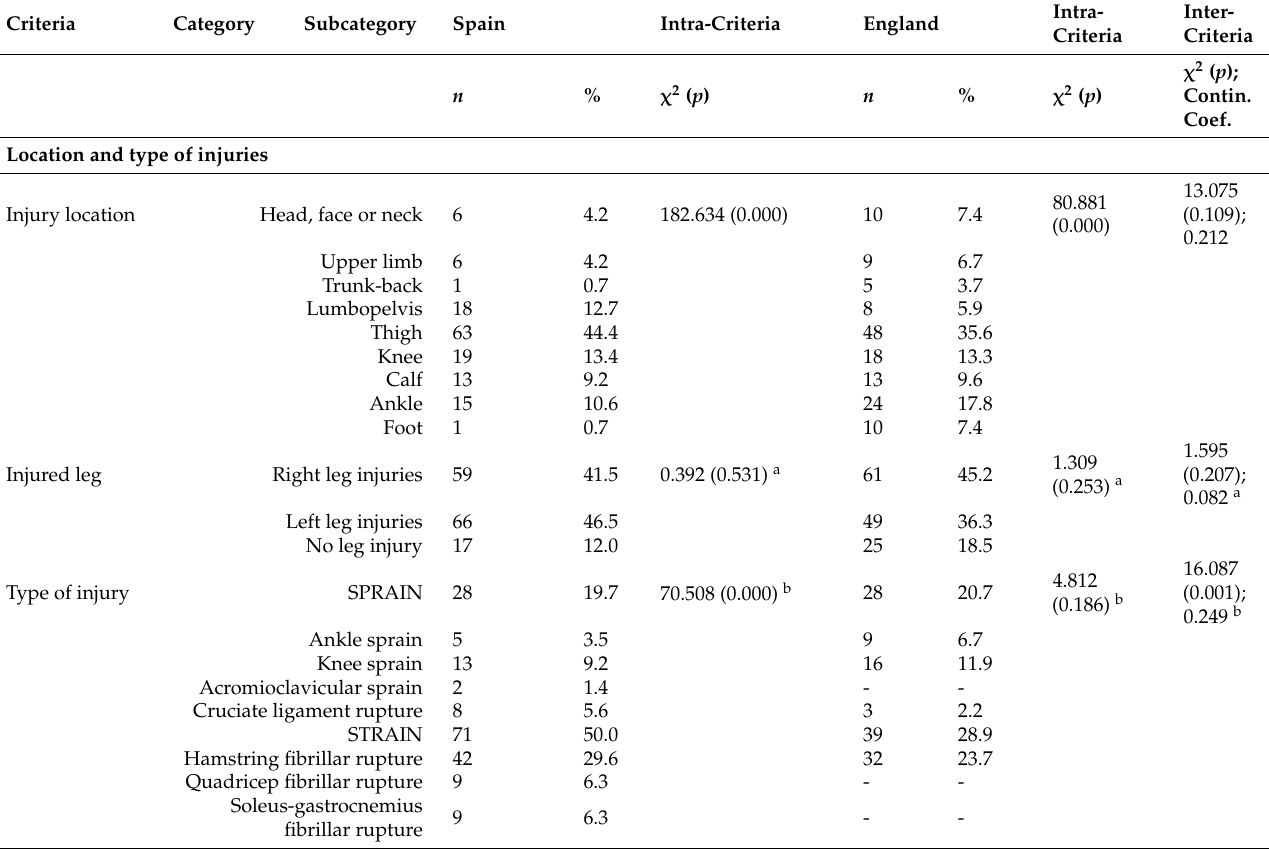
Table 1. Descriptive obtained values and the link between the